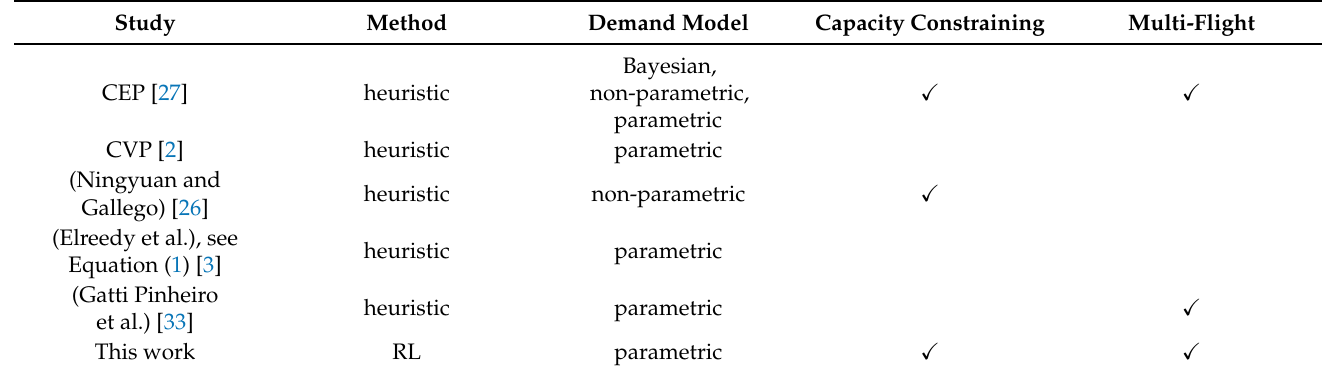
Table 1. Earning-while-learning literature